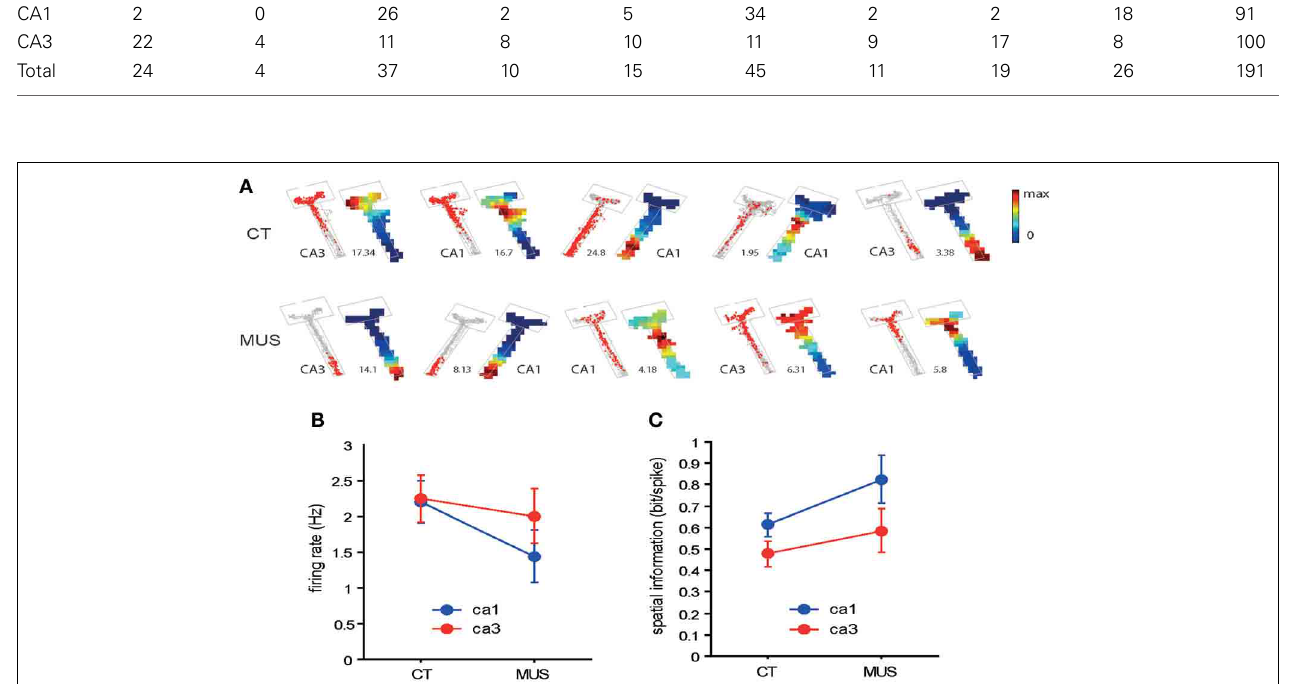
from 0 to maximum for each neuron. The neurons presented were not simultaneously recorded. (B) Overall firing rates of neurons in CA1 and CA3 in different drug conditions. No statistically significant differences were found between the two conditions. Mean ± s.e.m. (C) Comparison of spatial information in CA1 and CA3 neuronal firing between the two drug conditions. No statistical significance was observed between the two drug conditions. Mean ±